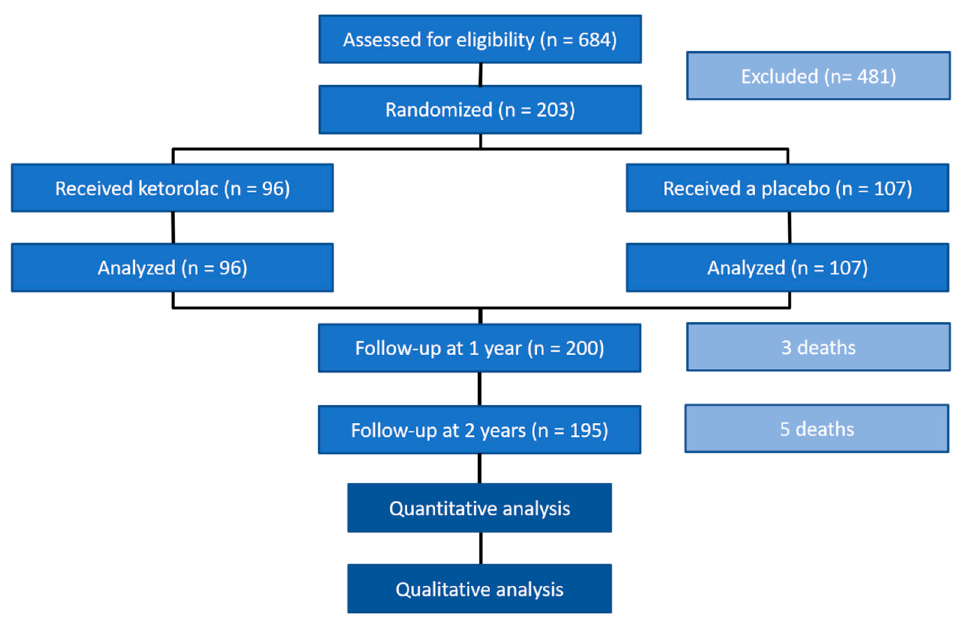
Figure 1. Study flow chart.